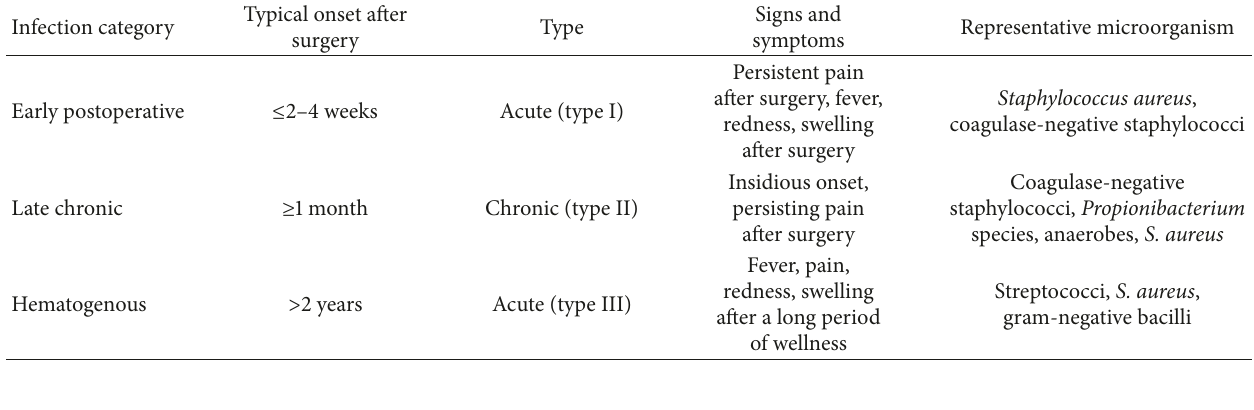
Table 4: Description of THA infection.